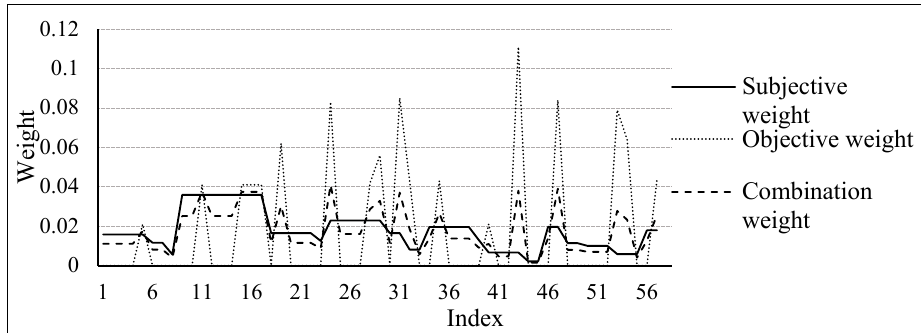
Figure 3. Comparison result chart of subjective weight, objective weight, and combined weight.